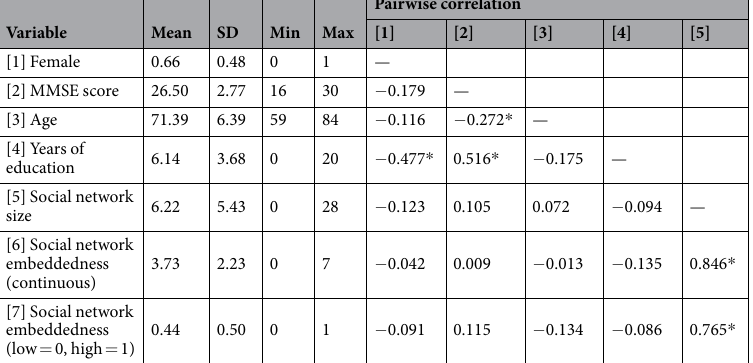
takes six years to complete elementary school in South Korea, the average years of education (6.14) is quite low, but accurately reflects rural Korean older population’s educational characteristics. Two social network indices were assessed using the complete network of Township K in South Korea (details about social network data construction are described in the methods section). First, social network size was meas- ured by the number of social connections the participants had in the complete network. Second, social network embeddedness was measured by k -core score 11 . A k -core group is composed of people who have at least k social connections with others in the same group. Since one can belong to several nested k -core groups from low k to high k , he or she takes the highest value of k as his or her k -core score. For example, A in Fig. 1 belongs to three kinds of k -core groups (a 1-core group composed of all 10 people in the graph, a 2-core group of 7 people, and a 3-core group of 4 people), thus A’s k -core score is 3, corresponding to the maximum of k . On the other hand, B’s k -core score is 2 since B is not a member of the 3-core group. Even though B has the same size of social networks as A (3), B cannot hold 3 social connections when c and d (having only two social connections in the 2-core